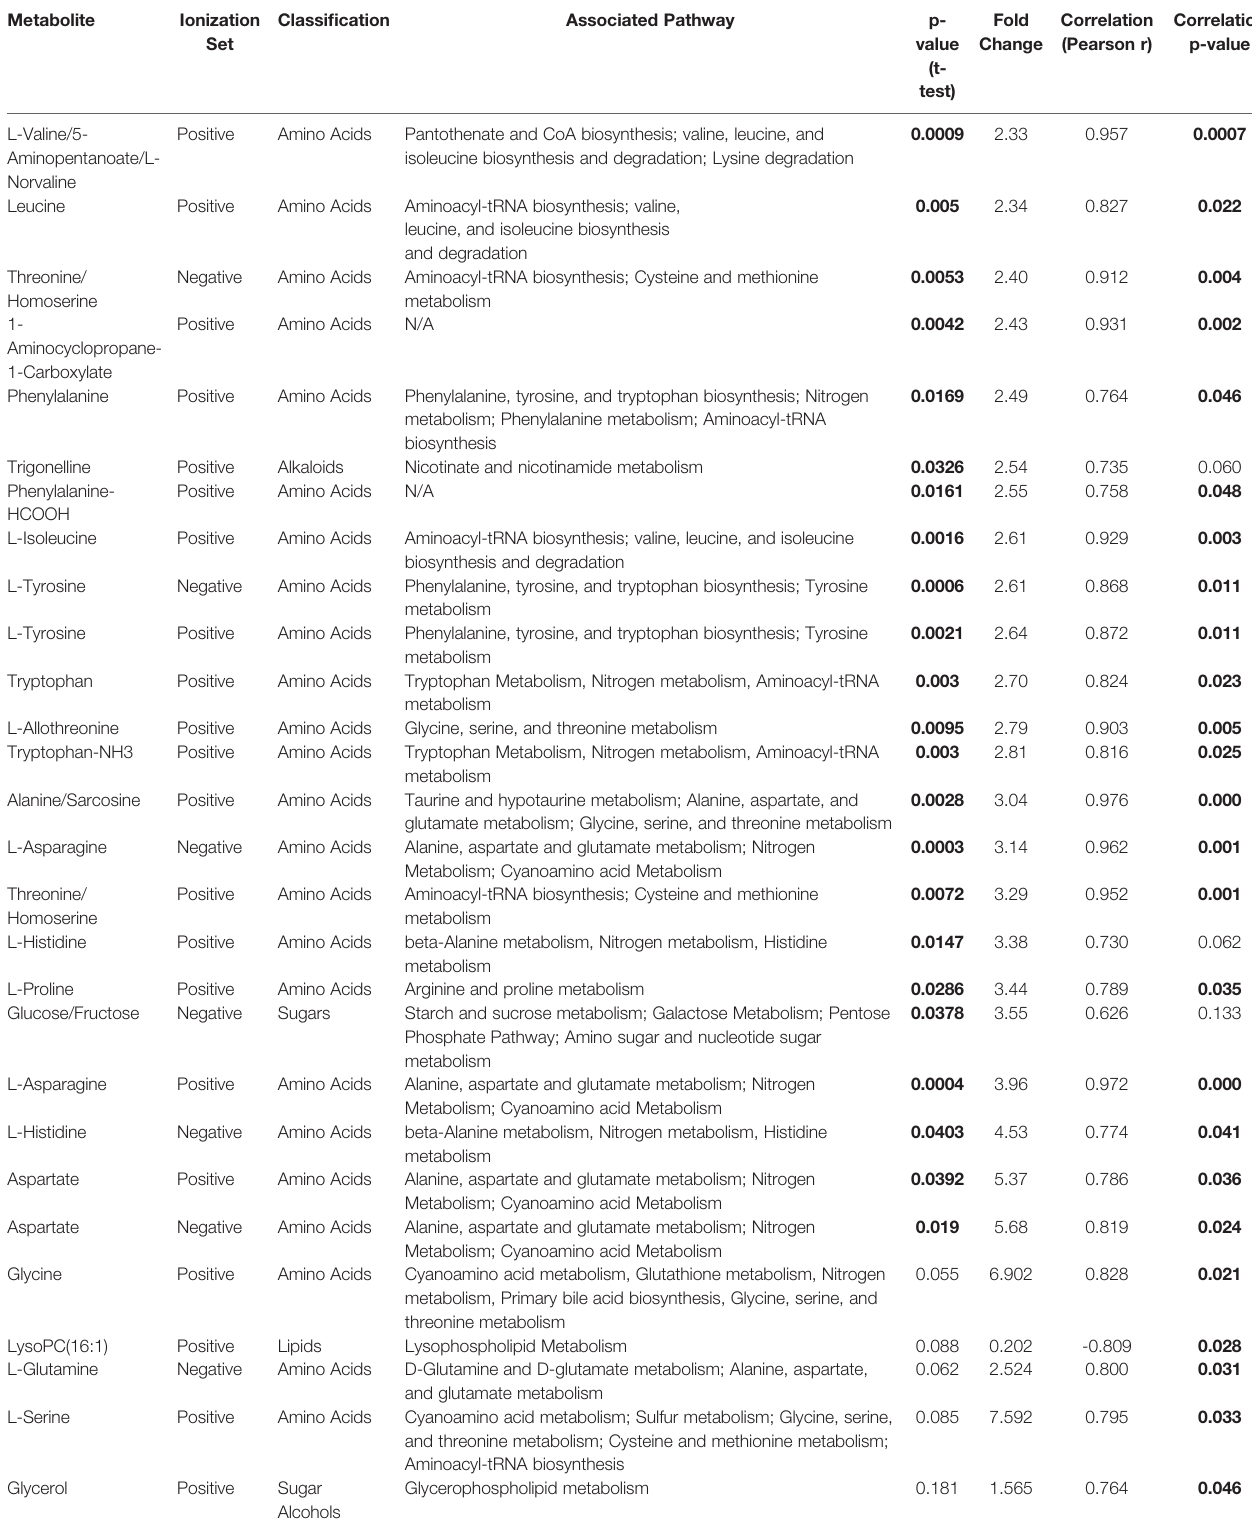
TABLE 2 | List of metabolites signi fi cantly associated with doxorubicin resistance in 7 AML cell lines.